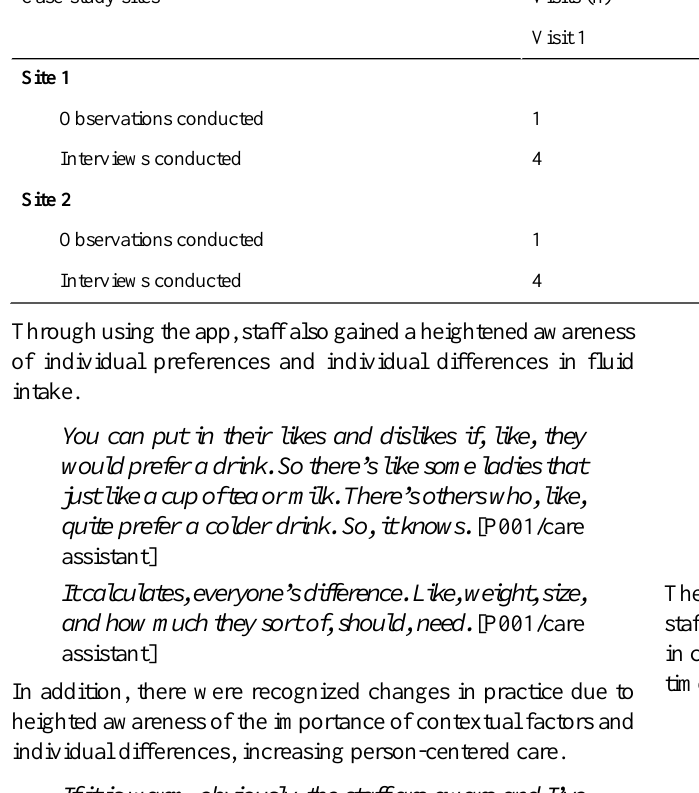
Visits (n)Case-study